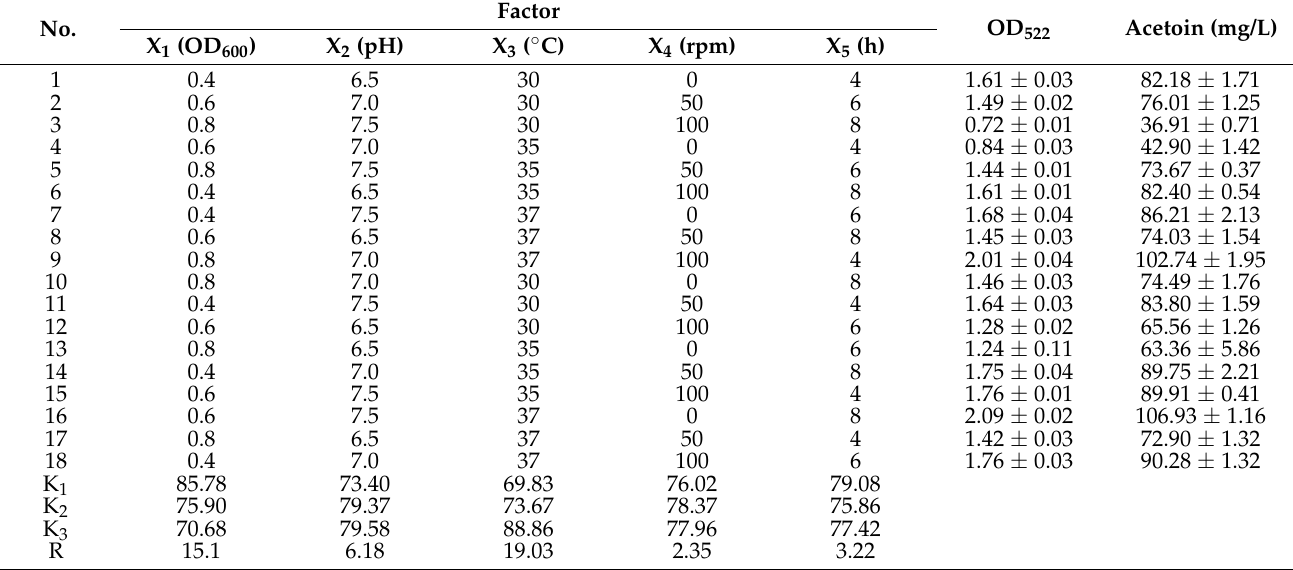
Table 3. The L 18 (3 5 ) orthogonal test applied for optimizing the production of acetoin a